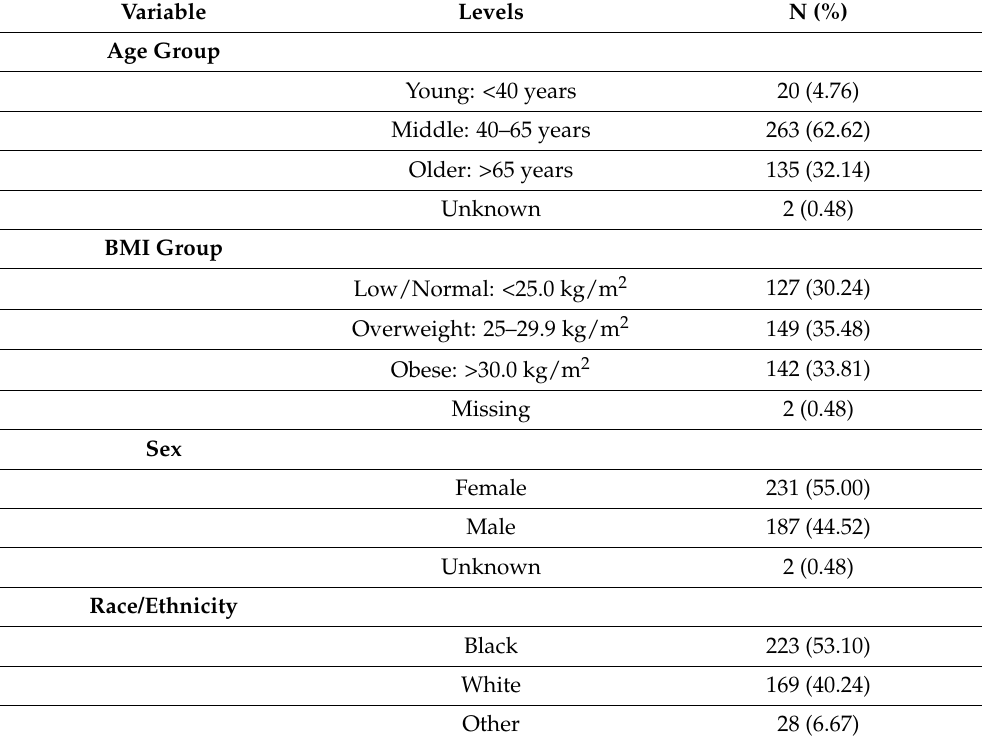
Table 1. Patient